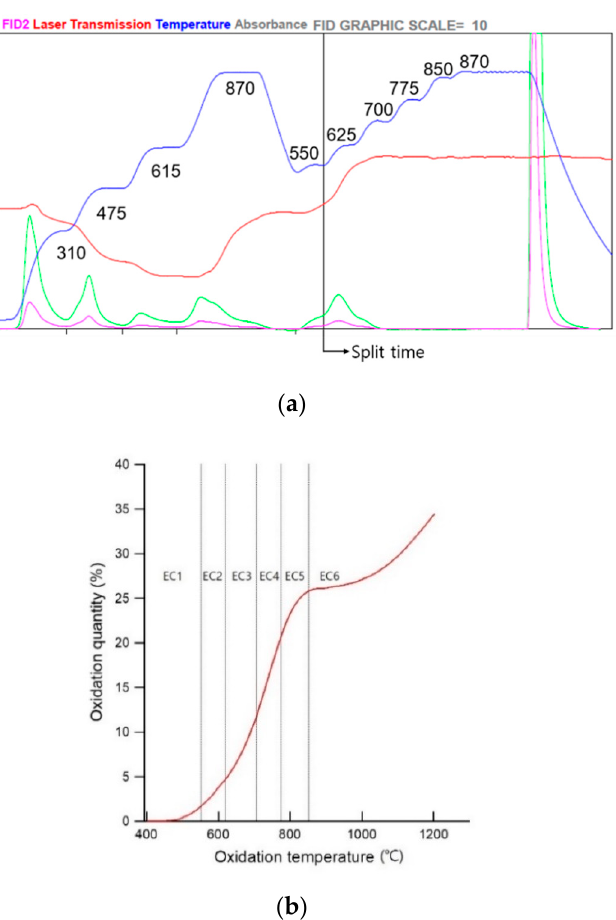
Figure 2. ( a ) An example of relative profiles of temperature, transmittance, absorbance and FID signals used in this study; ( b ) Carbon oxidation quantity as a function of temperature. The curve was adopted from another study